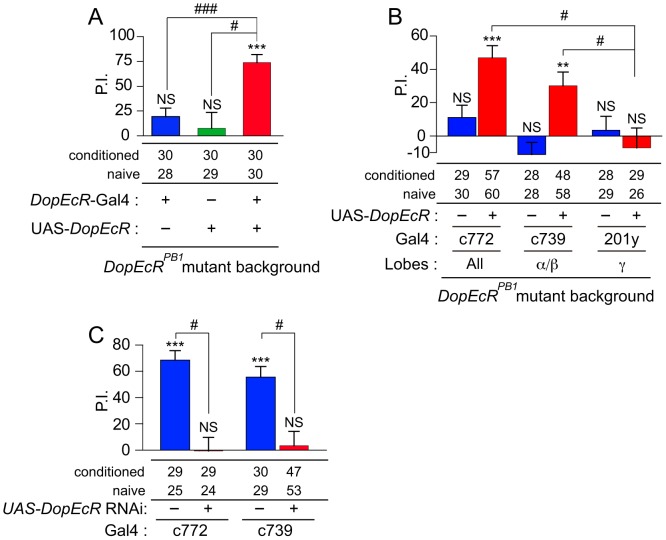
The mushroom body is critical for the DopEcR-dependent processing of courtship memory.(A) Rescue of the DopEcRPB1 memory defect by expression of wild-type DopEcR transgene using the DopEcR-Gal4 driver. (B) Rescue of DopEcRPB1 memory defect by expression of wild-type DopEcR transgene under control of the MB-specific c772, c739 and 201 y drivers. Note that MB-Gal4 lines drive reporter expression in different subsets of MB neurons (see text). (C) Courtship memory defect induced by MB-specific expression of the DopEcR RNAi using the c772 and c739 drivers. The presence or absence of courtship memory was evaluated by applying Mann–Whitney U-test to naïve and conditioned flies. Statistical significance is shown above each bar. NS, no significant difference. **, P<0.01; ***, P<0.001. Sample numbers for naïve and conditioned flies are shown under each graph. PIs were analyzed using Student's t-test or Krustal-Wallis One-Way ANOVA, followed by Dunn's pairwise test for multiple comparisons. #, P<0.05; ###, P<0.001. Error bars (s.e.m.).